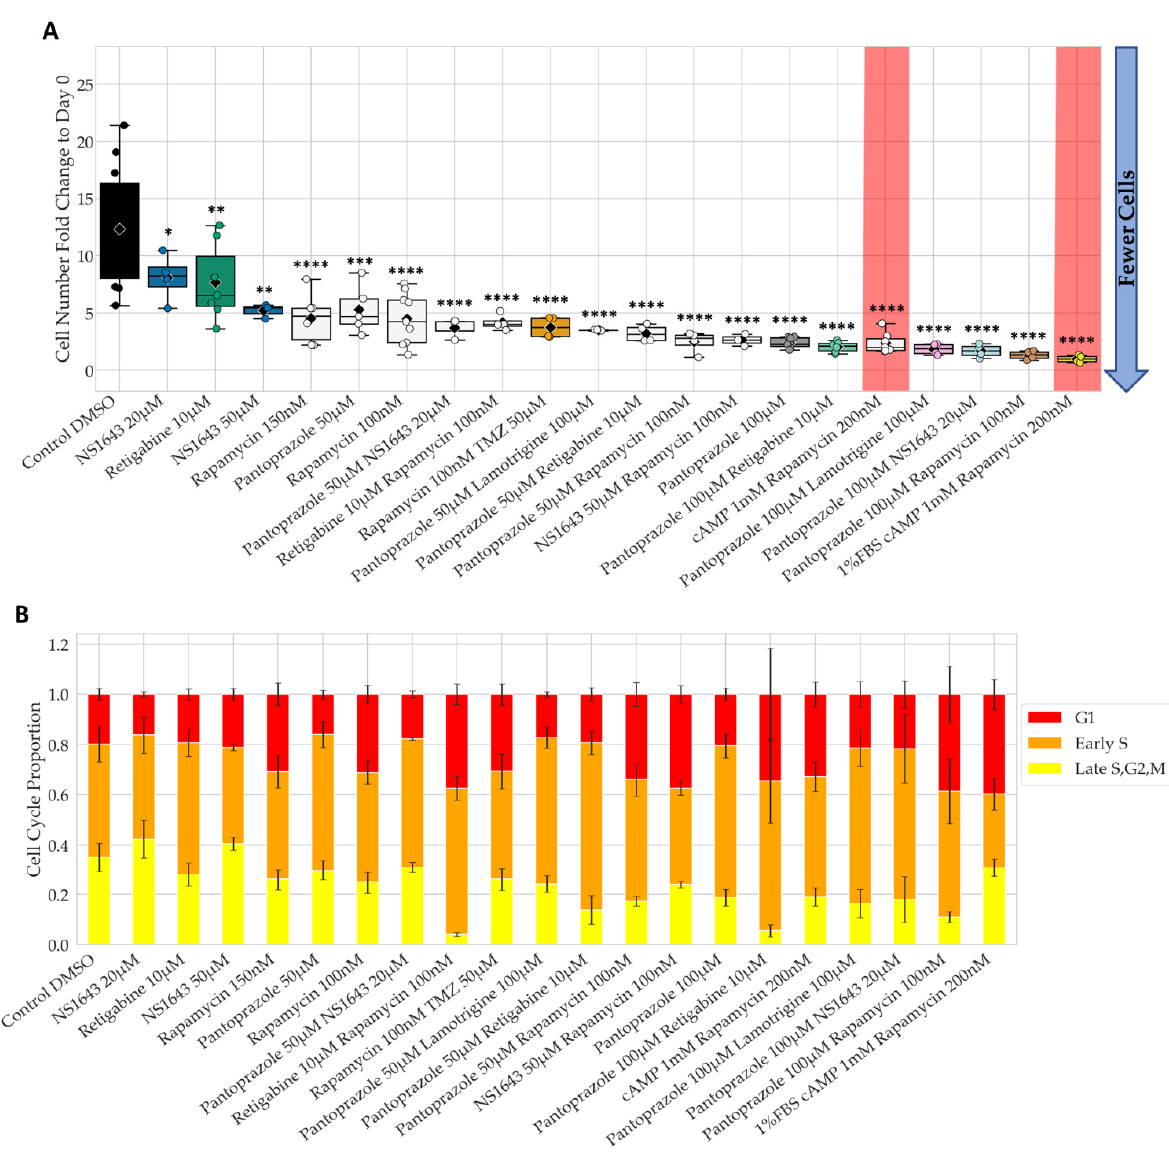
Figure 1. NG108-15 Proliferation is Significantly Lowered with Bioelectric Treatment and Show Changes